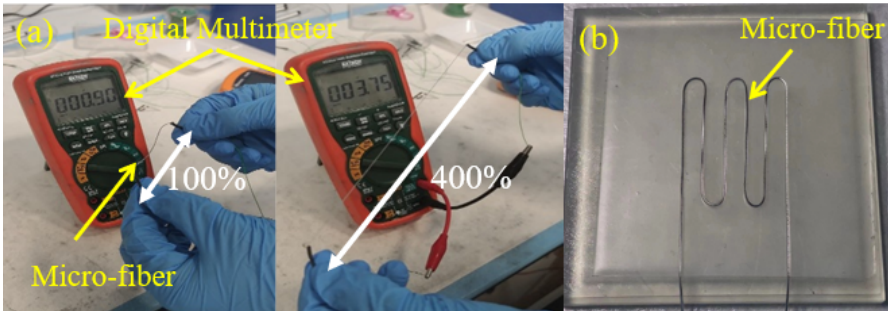
Figure 2. ( a ) Stretching test of liquid metal microfiber from 100% ( left ) to 400% ( right ), and the digital multimeter is utilized to measure the change of the resistance value; ( b ) shows the basic demonstration of the sensor layout.